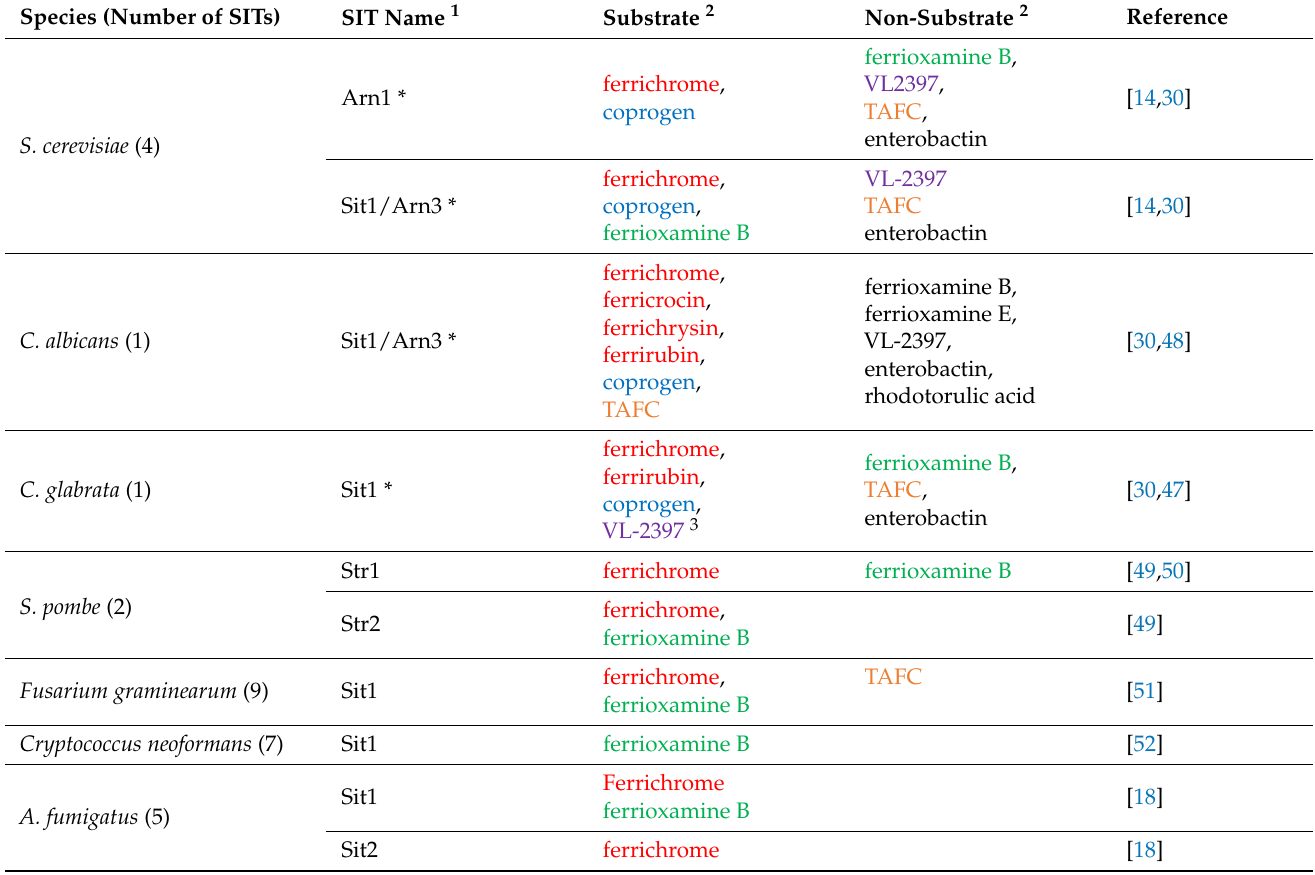
Table 3. Previously identified ferrichrome and ferrioxamine transporting SITs including identified substrate specificities. Species (Number of